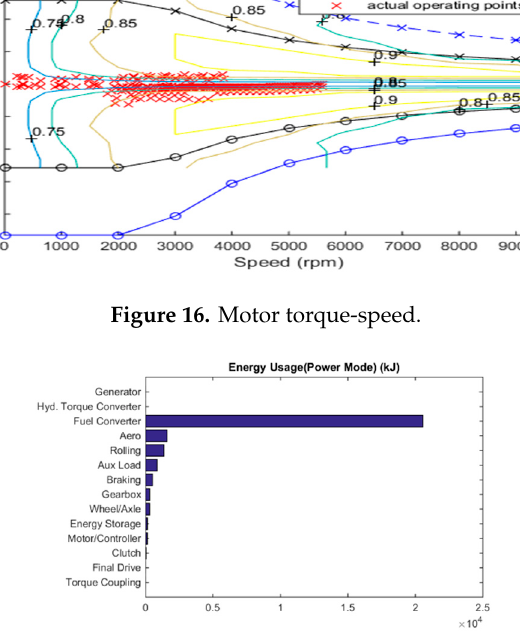
Figure 17. Energy use power mode. Figure 16. Motor torque-speed.